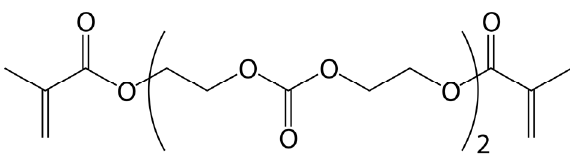
Figure 1. Chemical structure of OCM-2 oligomer.